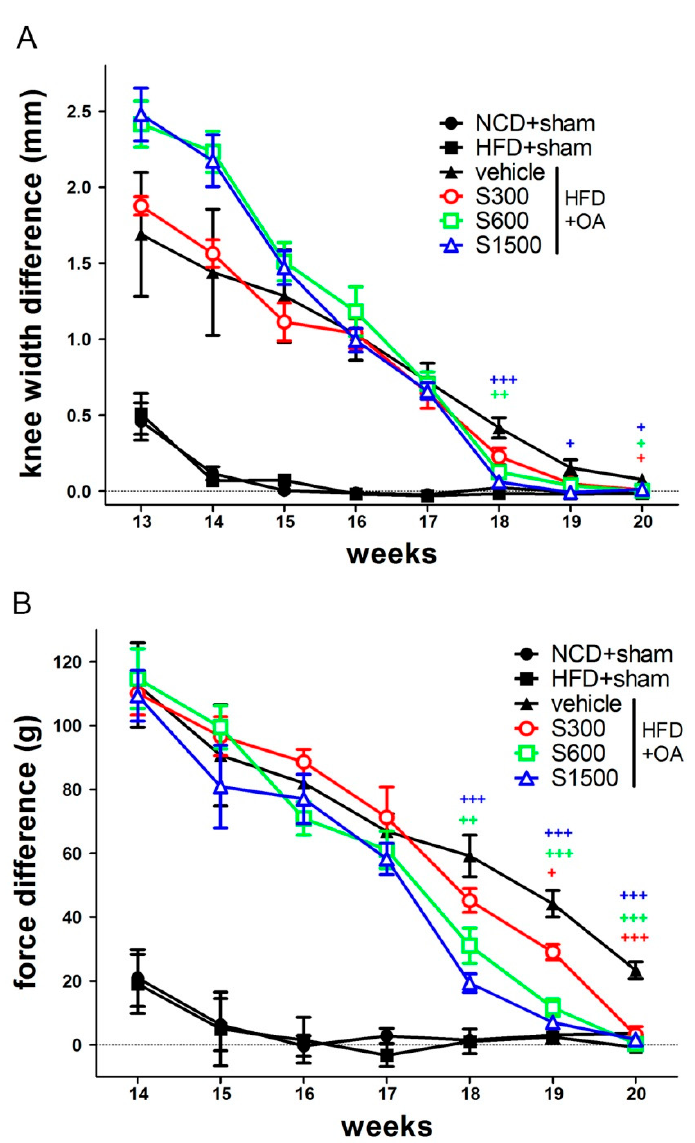
Figure 5. E ff ects of Shiikuwasha Extract on knee width and incapacitance after ACLT / MMx. ( A ) The width of the knee joint was measured weekly for eight weeks with calipers starting in week 13. ( B ) An incapacitance test was used to measure the weight bearing of the hind limb weekly for 7 weeks starting in week 14. Data were the di ff erence between the weights applied to the contralateral and ipsilateral limbs, expressed as the mean ± SEM ( n = 6). Two-way ANOVA and Dunnett’s multiple comparisons test were used to analyze the data. + p < 0.05, ++ p < 0.01, +++ p < 0.001, when compared to the vehicle group.